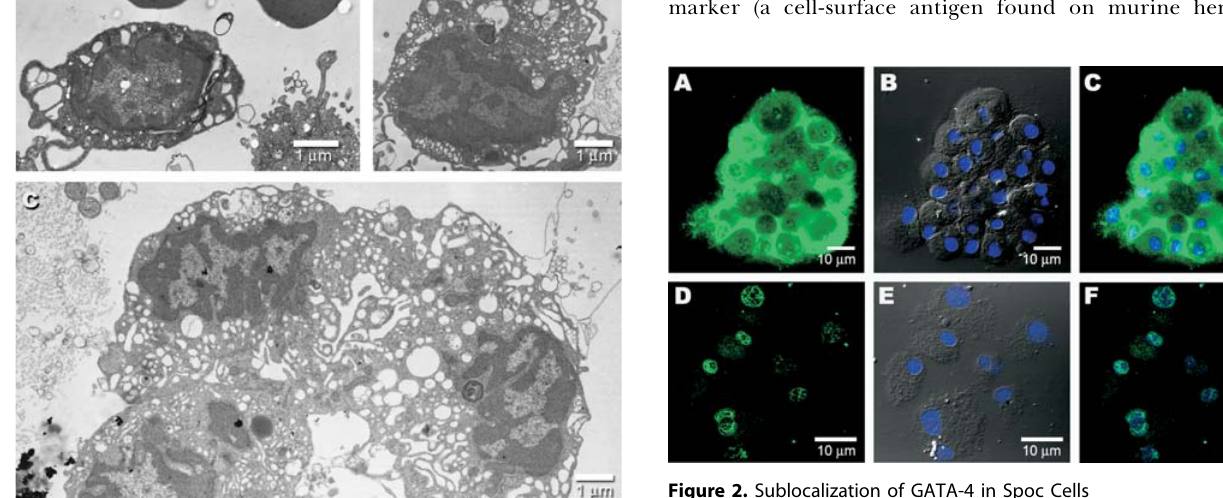
Figure 2. Sublocalization of GATA-4 in Spoc Cells (A) GATA-4 is detected in the cytoplasm of day 10 Spoc cells (cytospin). (B) Nomarski image of (A), showing DAPI-stained blue nuclei. (C) Merge image showing nuclei and GATA-4 staining. (D) When Spoc cells are incubated with 20 l M isoproterenol for 1 h, the GATA-4 nuclear staining is seen. (E) Nomarski image of (D). (F) Merge of (D) and (E), showing sublocalization of GATA-4 to